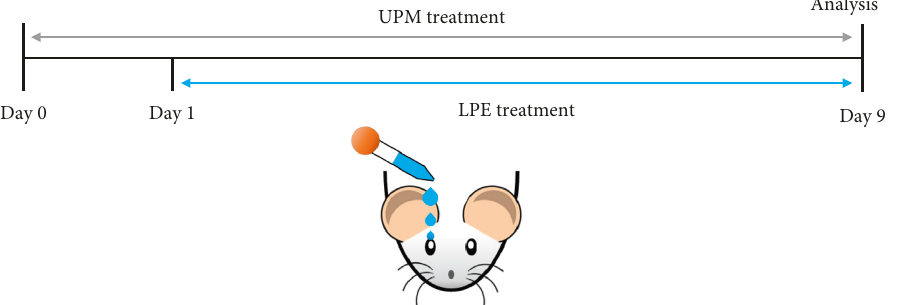
Figure 1: Schematic illustration of animal experiment design. UPM, urban particulate matter; LPE, Liriope platyphylla Prism 7.0 Software (GraphPad, San Diego, CA, USA). The data from the fluorescein staining score and irregularity p values < 0.05 indicated statistical significance.